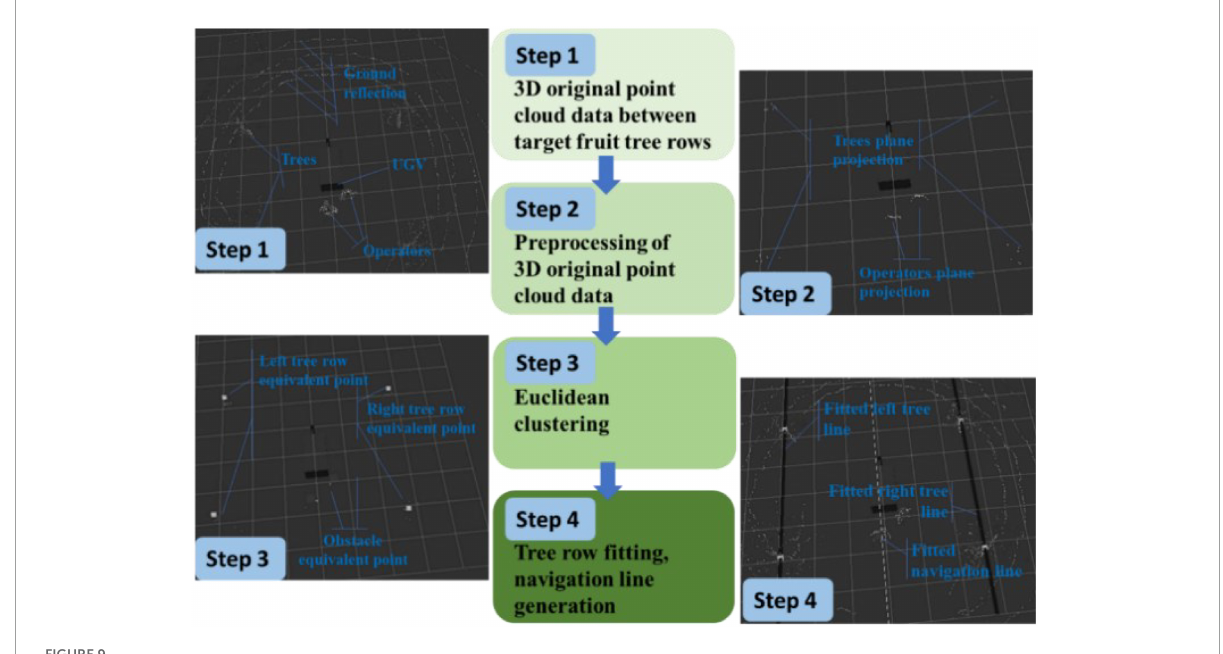
FIGURE9 Navigation line extraction rules among fruit